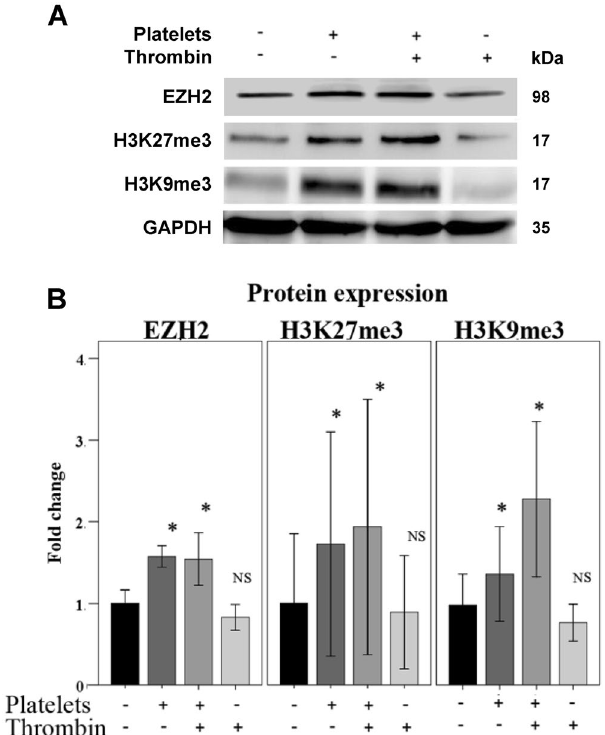
Figure 5. Platelets up-regulate the expression of EZH2, H3K27me3, and H3K9me3 in endometriotic epithelial cells. Western blotting (upper panel) and quantification (lower panel) of EZH2, H3K27me3, and H3K9me3 in 11Z cells treated with buffer (PBS), platelets, activated platelets or thrombin alone (n = 5). NS: not statistically significant. The cropped blots are used in the figure. The membranes were cut prior to exposure so that only the portion of gel containing desired bands would be visualized, as described in materials and methods. * P <